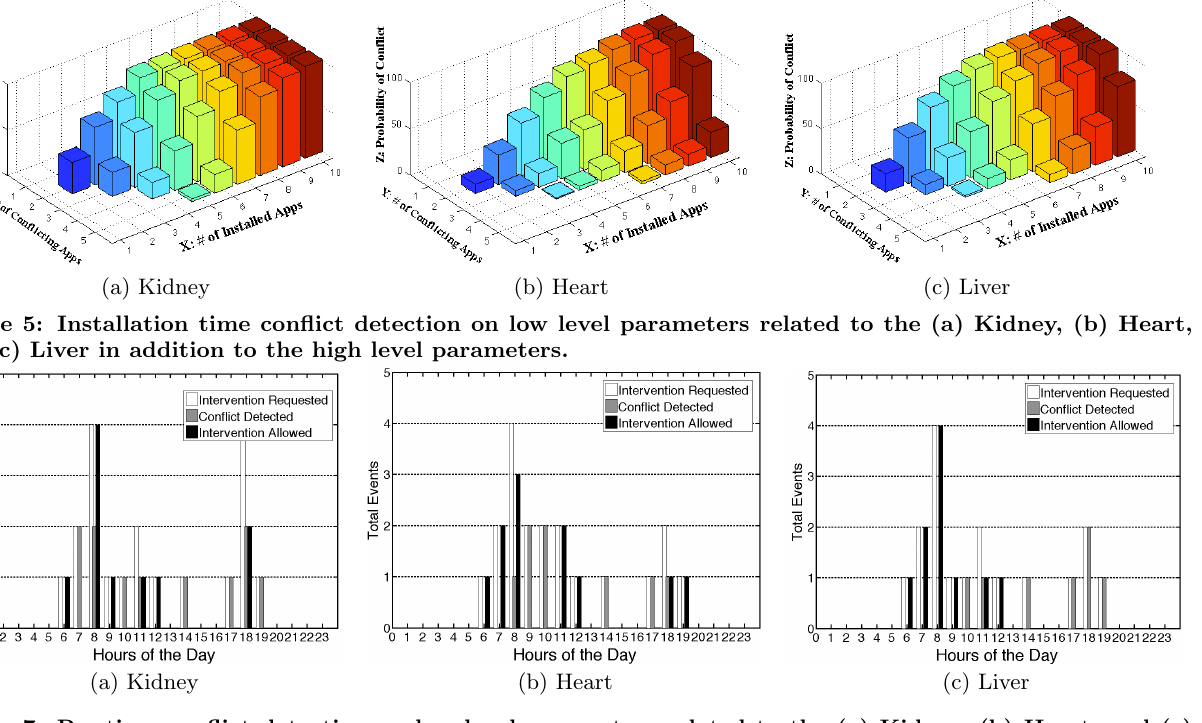
Figure 7: Runtime conflict detection on low level parameters related to the (a) Kidney, (b) Heart, and (c) Liver in addition to the high level parameters.